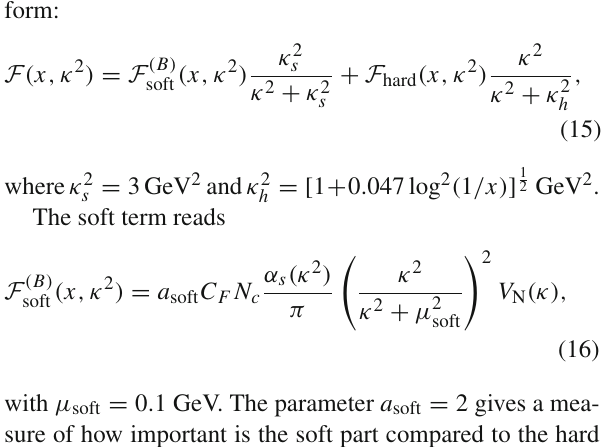
Fig. 2 Q 2 -dependence of the diffractive slope for the exclusive ρ - meson leptoproduction (Eq. (12)) compared to the H1 data from Ref.